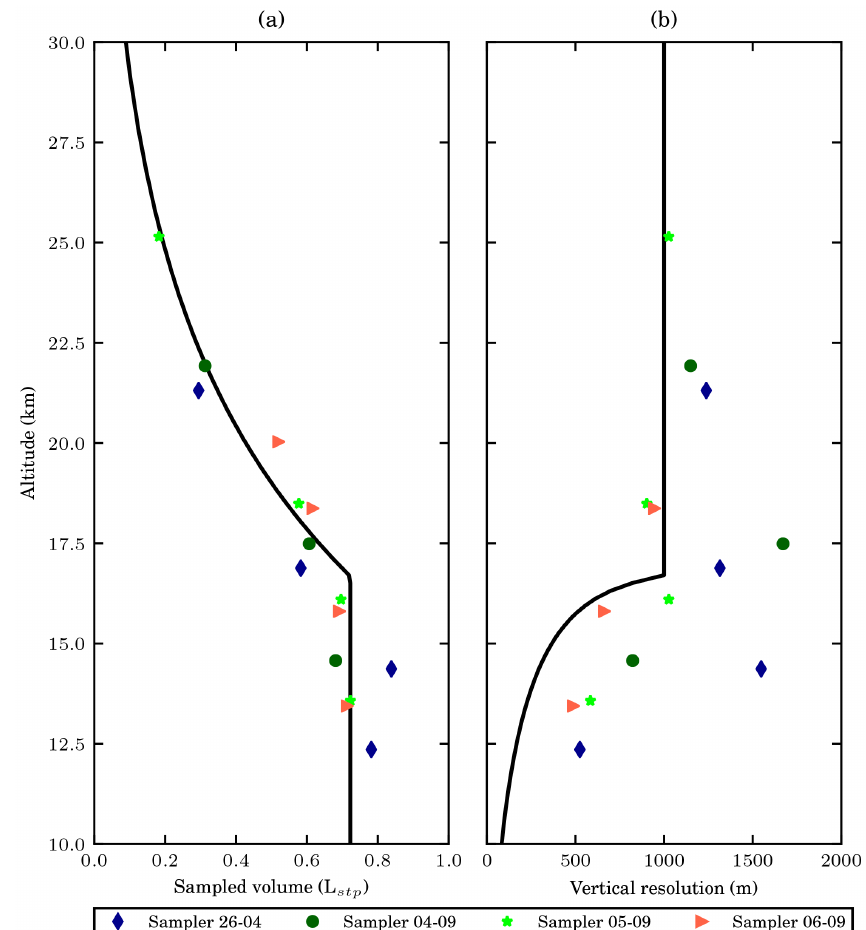
Figure 4. (a) The altitude profile of the sample size of the collected 15 air samples. The estimated sample size with the sampling time of 200s, and a maximum allowed bag pressure of 280hPa, using the empirical relations used in Sect. 4 is shown plotted in black, similar to in Fig. 3d. The uncertainty in volume presented is 7.6mL. (b) The altitude profile of the vertical resolution of the collected samples. Different colours and symbols are used to label the samples from different flights. The vertical resolution of the highest sample from the flight on 6 September 2017 is not shown as the number is abnormally large caused by fast descending speed after the burst of the balloon. The black solid line sows the expected vertical resolution, assuming an ascent speed of 5ms − 1 . Sampling time is calculated using the empirical relations discussed in Sect. 4, with a maximum allowed pressure of 280hPa. If this is not reached we have used the maximum sampling time of 200s, which corresponds to a vertical resolution of